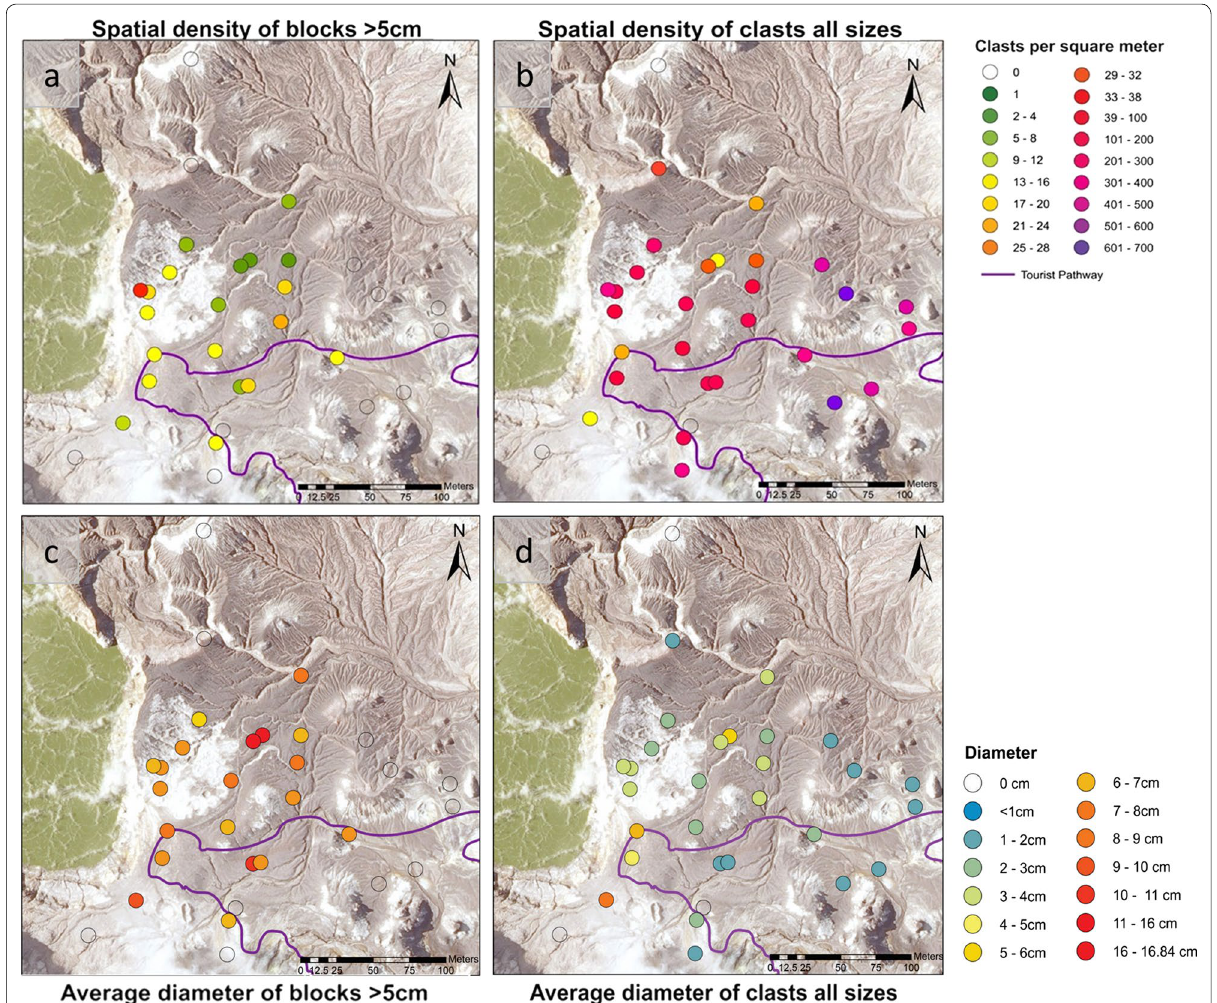
Fig. 11 Maps illustrating the distribution of a number of all mappable clasts at all surveyed sites, b the number of only clasts > 5 cm diameter, c the average diameter of clasts > 5 cm at all surveyed sites and d the average diameter of all clasts at all surveyed